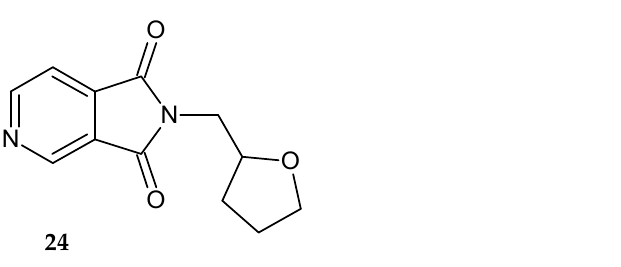
Figure 19. 2-((Tetrahydrofuran-2-yl)methyl)-2 H -pyrrolo[3,4- c ]pyridine-1,3-dione 24 . Figure 19. 2 ‐ ((Tetrahydrofuran ‐ 2 ‐ yl)methyl) ‐ 2 H ‐ pyrrolo[3,4 ‐ c ]pyridine ‐ 1,3 ‐ dione 24 . Figure 19. 2 ‐ ((Tetrahydrofuran ‐ 2 ‐ yl)methyl) ‐ 2 H ‐ pyrrolo[3,4 ‐ c ]pyridine ‐ 1,3 ‐ dione 24 .